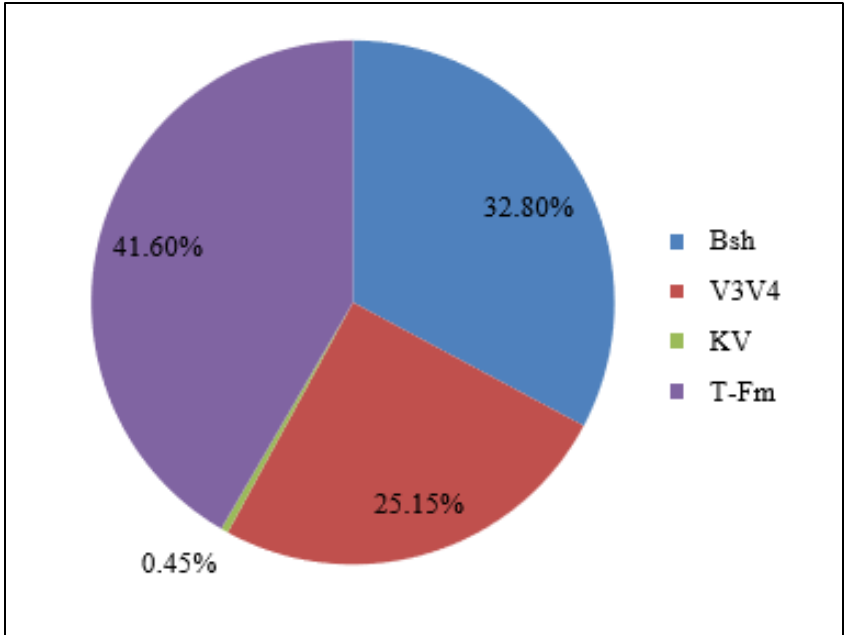
Figure 2. Distribution of sites by the cumulative incremental oil production due to RJD. The greatest amount of the incremental production was registered at the T-Fm sites (42%—8386 thousand barrels); a comparable amount was collected from the Bsh sites (33%—6610 thousand barrels); they are followed by the V3V4 sites (25%—5059 thousand barrels) and an insignificant contribution was made by the KV1 sites (0.5%—87 thou- sand